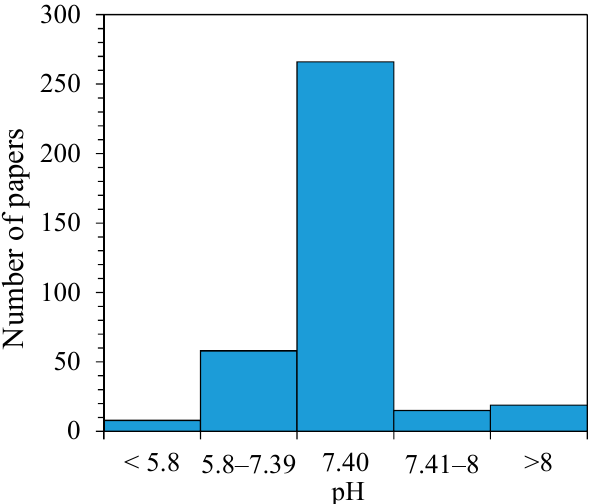
Figure 5. Buffer pH values used to study albumin–ligand binding in the papers from the dataset .